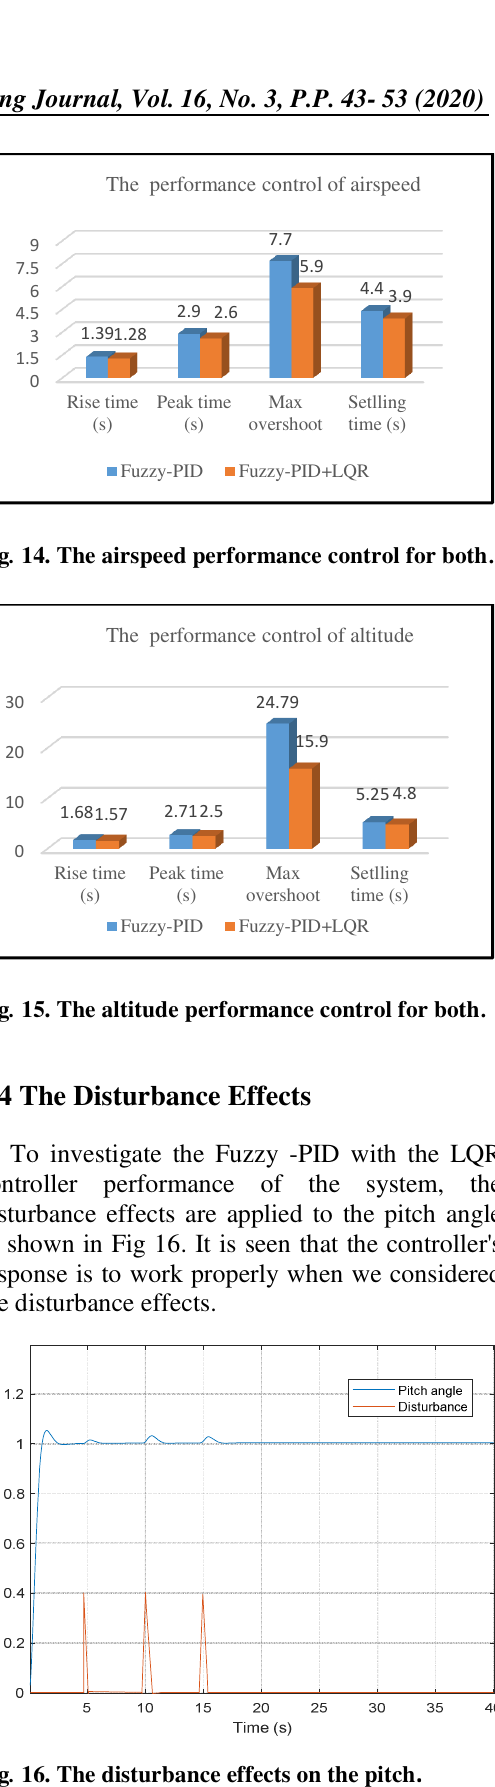
Fig . 16. The disturbance effects on the pitch